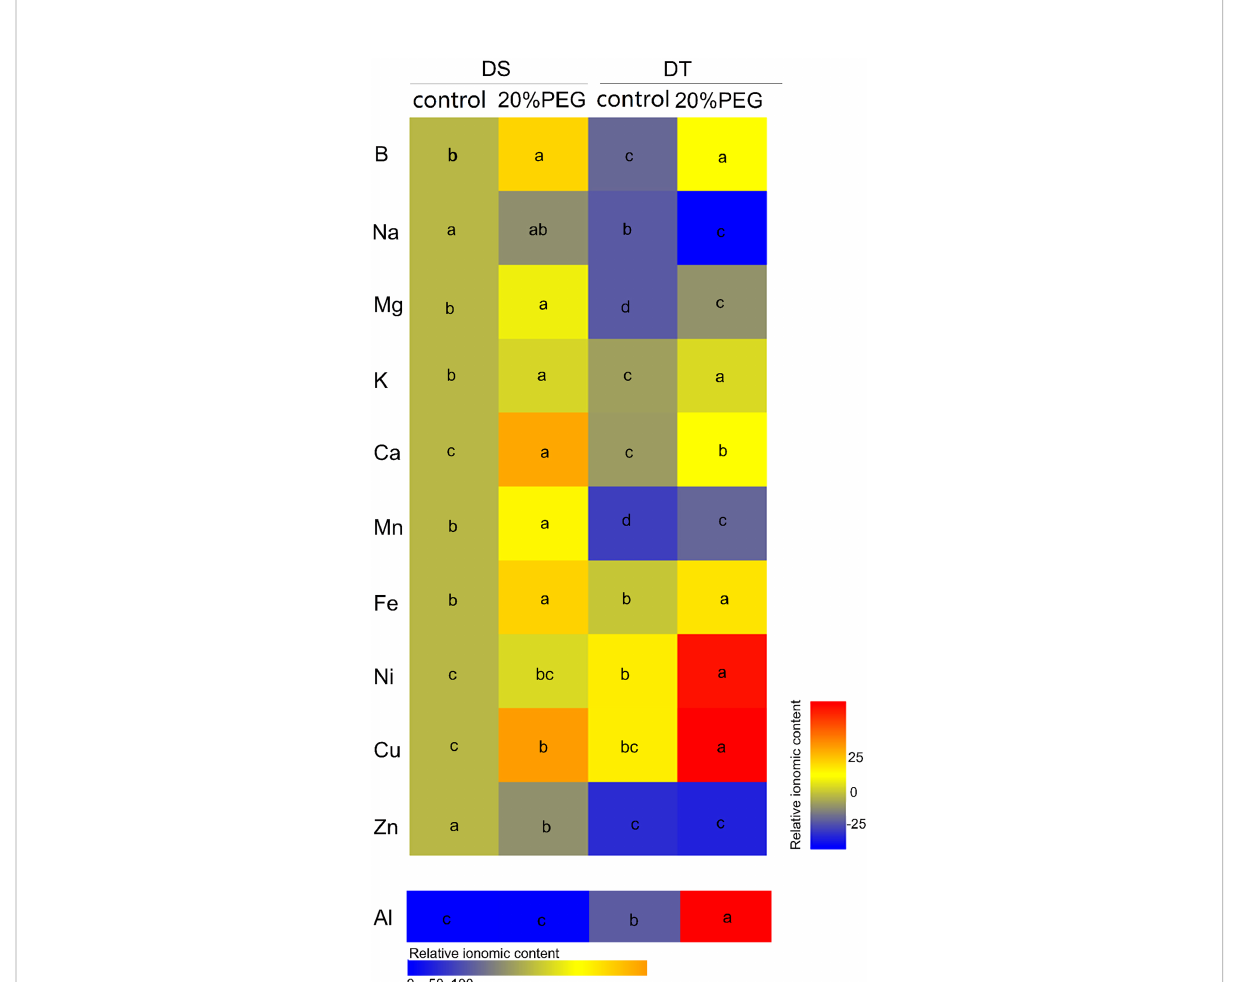
FIGURE 2 Mineral elemental accumulation in shoots of drought-tolerant (DT) and drought-sensitive (DS) genotypes grown under control or osmotic stress conditions. Mineral elemental concentrations were determined using inductively coupled plasma mass spectrometry (ICP-MS). Results are presented relative to the control DS values calculated from numeric values presented in Supplementary Table 5. Different letters indicate signi fi cant differences at P < 0.05 based on one-way analysis of variance (ANOVA) (Fisher ’ s Duncan